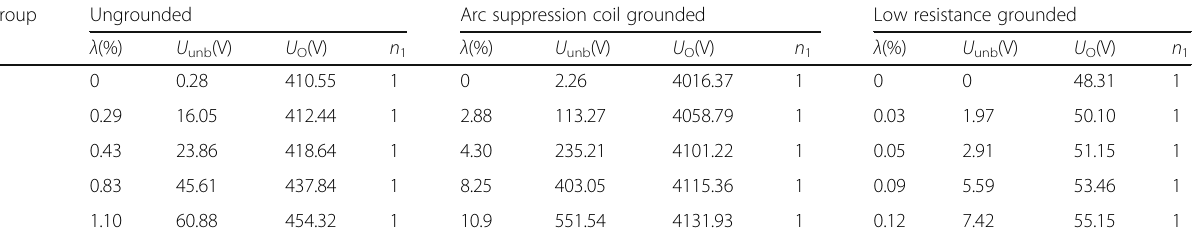
Table 3 Influence of system asymmetry on neutral voltage and sequence current ratio Group Ungrounded Arc suppression coil grounded Low resistance grounded